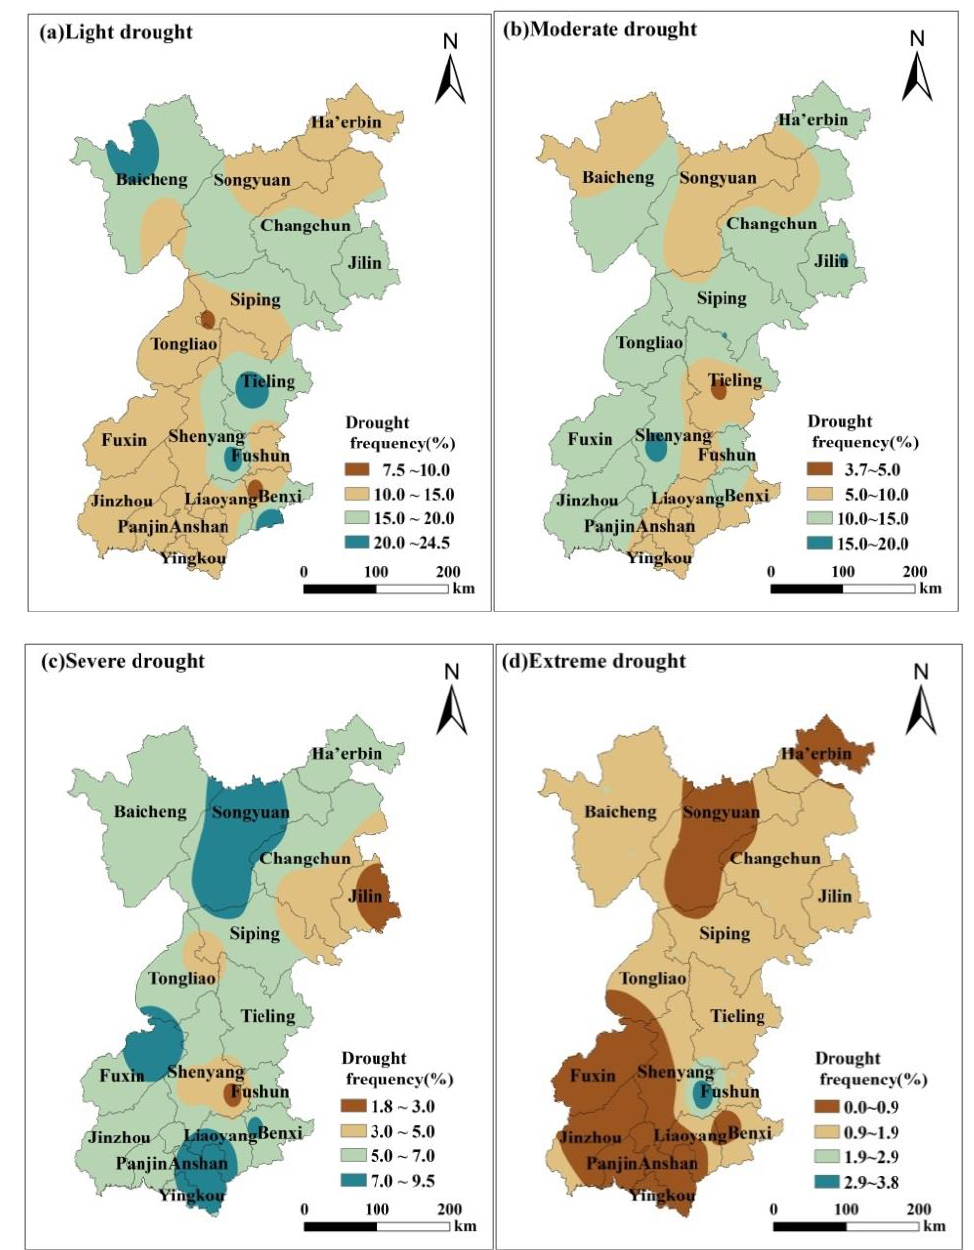
Figure 5. Spatial distribution of the frequencies of light drought ( a ); moderate drought ( b ); severe drought ( c ); and extreme drought ( d ) during the period 1965 – 2017.